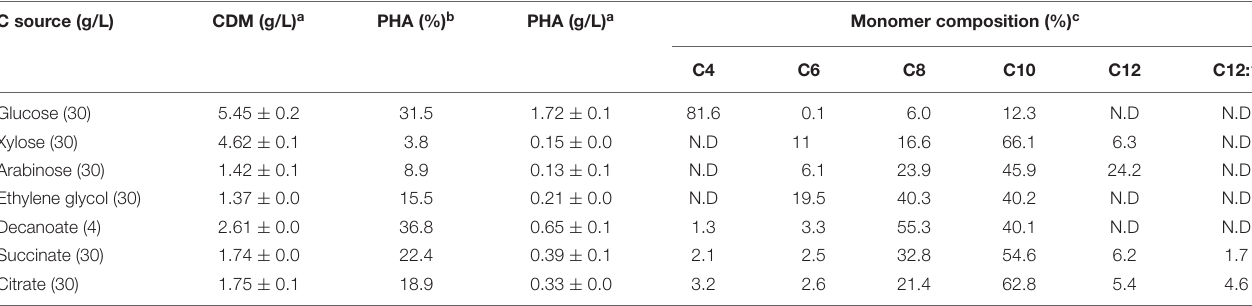
TABLE 3 | Monomer composition, biomass, and PHA titers displayed by Pseudomonas sp. MPC6 in shaking flask experiments after 96 h